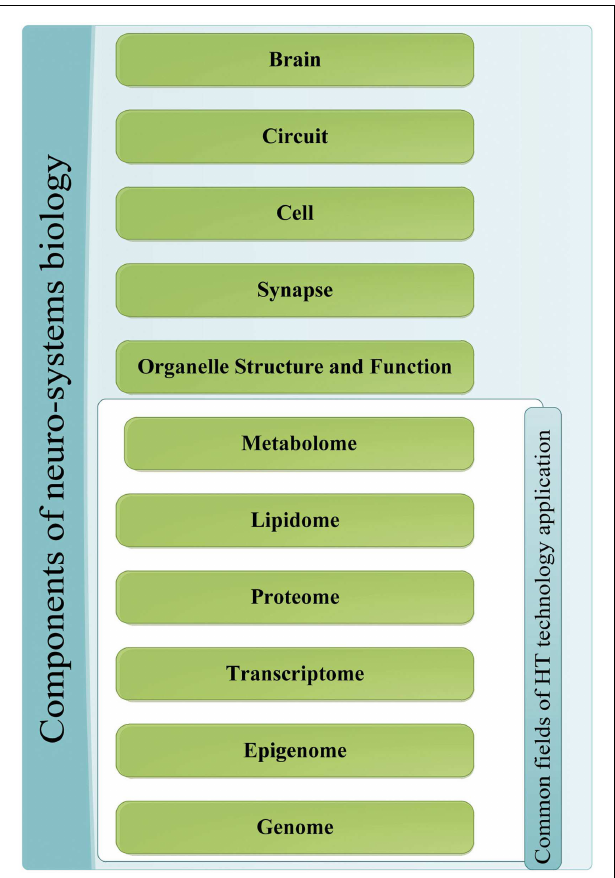
FIGURE 1 | Components of neuro-systems biology. The different sources of information for the application of systems biology to NP diseases; the components that are a common target of HT-discovery tools have been grouped